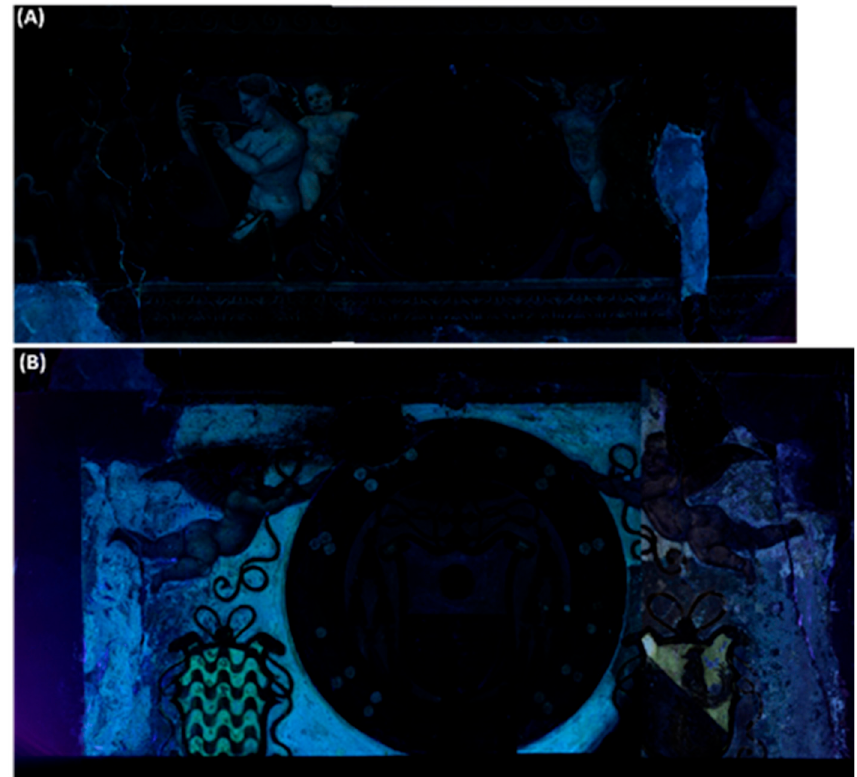
Figure 7. UVF photomosaic of the wall paintings after the almost complete removal of the scialbo . The upper frieze ( A ) and the Riario coat of arms ( B ).